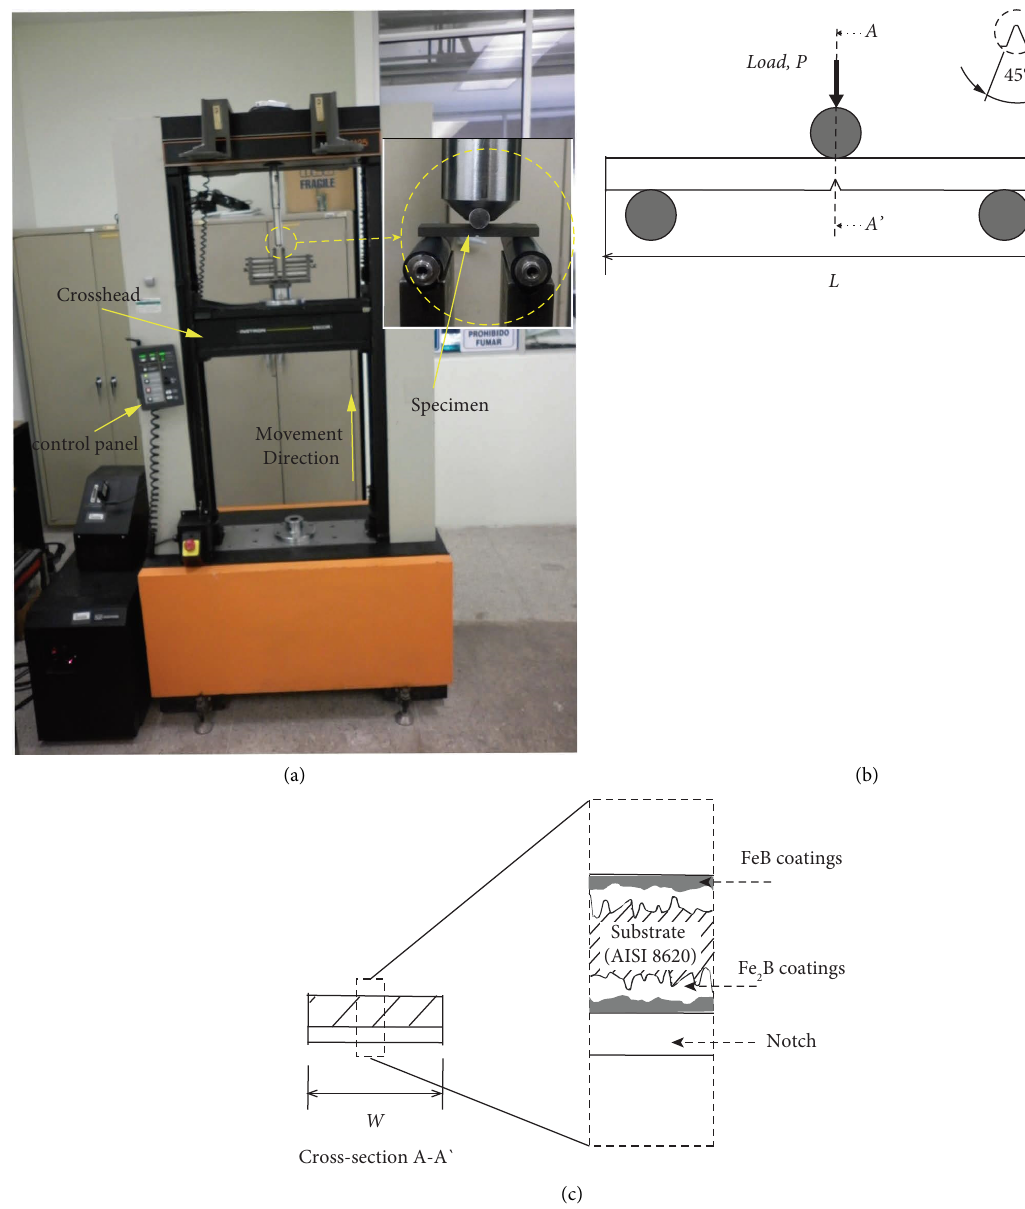
Figure 3: Schematic of the three-point bending setup: (a) photography of universal testing machine, (b) schematic arrangement, and (c) cross section on AISI 8620